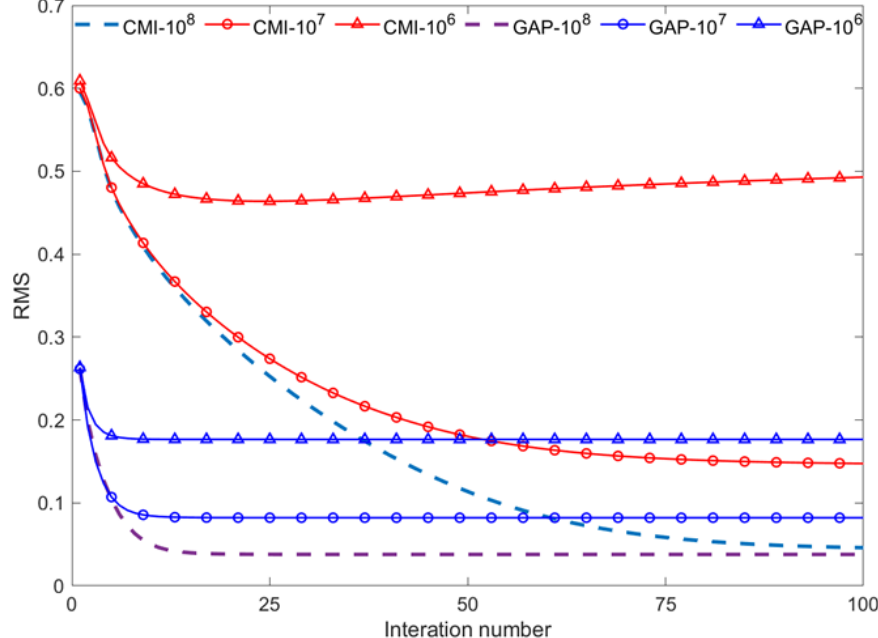
Figure 4. Convergence curve of the two algorithms in near-field geometry under 3 levels of photon flux. The RMS using our proposed algorithm converges relatively fast and reaches a lower RMS value.